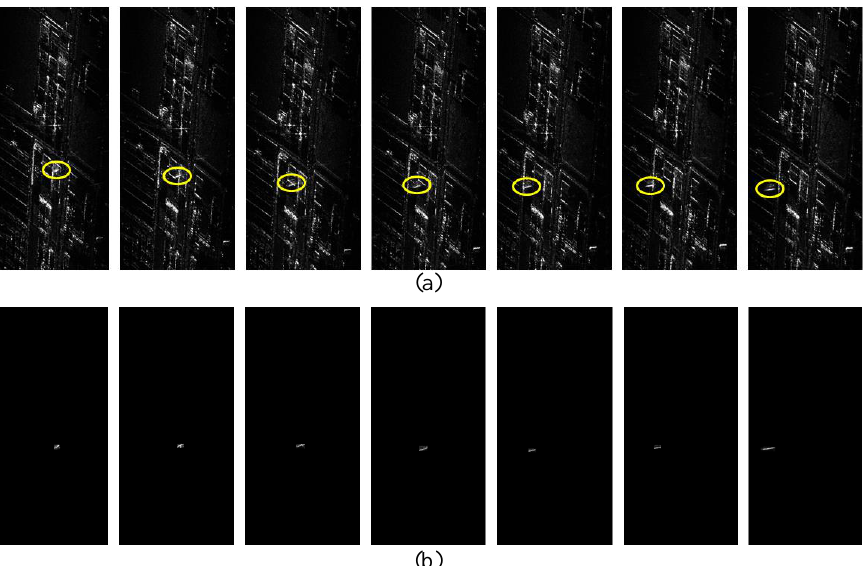
Figure 11. Moving target detection for T2. ( a ) Subaperture images before detection. ( b ) Subaperture images after